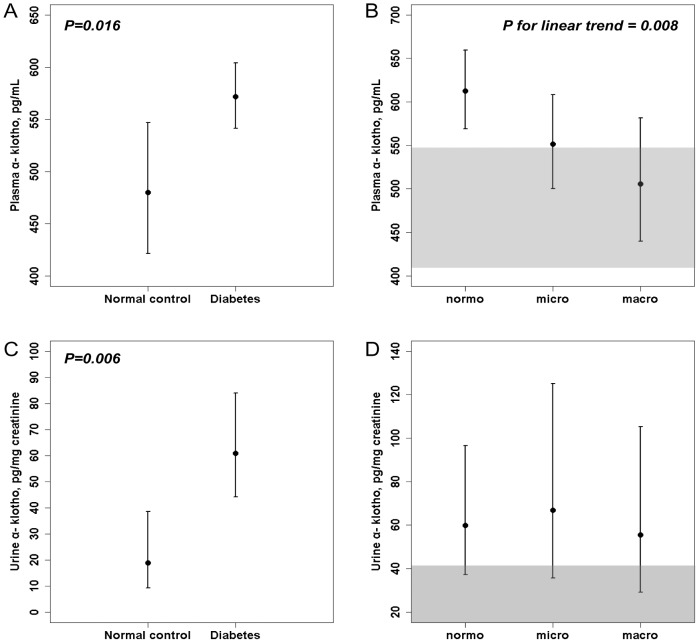
Plasma (A,B) and urine (C,D) levels of soluble α-klotho in normal participants (n = 25) and patients with type 2 diabetes (n = 147).Plasma and urine α-klotho levels were higher in diabetes patients with relatively preserved renal function than the non-diabetic controls (A,C). The diabetes patients were categorized into 3 groups according to urine ACR: ACR <30 mg/g creatinine (normoalbuminuria group, n = 75), ACR 30–299 mg/g creatinine (microalbuminuria group, n = 42), and ACR ≥300 mg/g creatinine (macroalbuminuria group, n = 30). Plasma α-klotho levels decreased in proportion to urinary albumin excretion, although urinary α-klotho levels were stable with increasing urinary albumin excretion (B,D). Data of non-diabetic control are expressed as a shaded area for the reference (B, D). Data are presented as geometric means and 95% CIs as an error bar plot. P-values calculated using the log-transformed values are shown in the graph. normo; normoalbuminuria, micro; microalbuminuria, macro; macroalbuminuria.